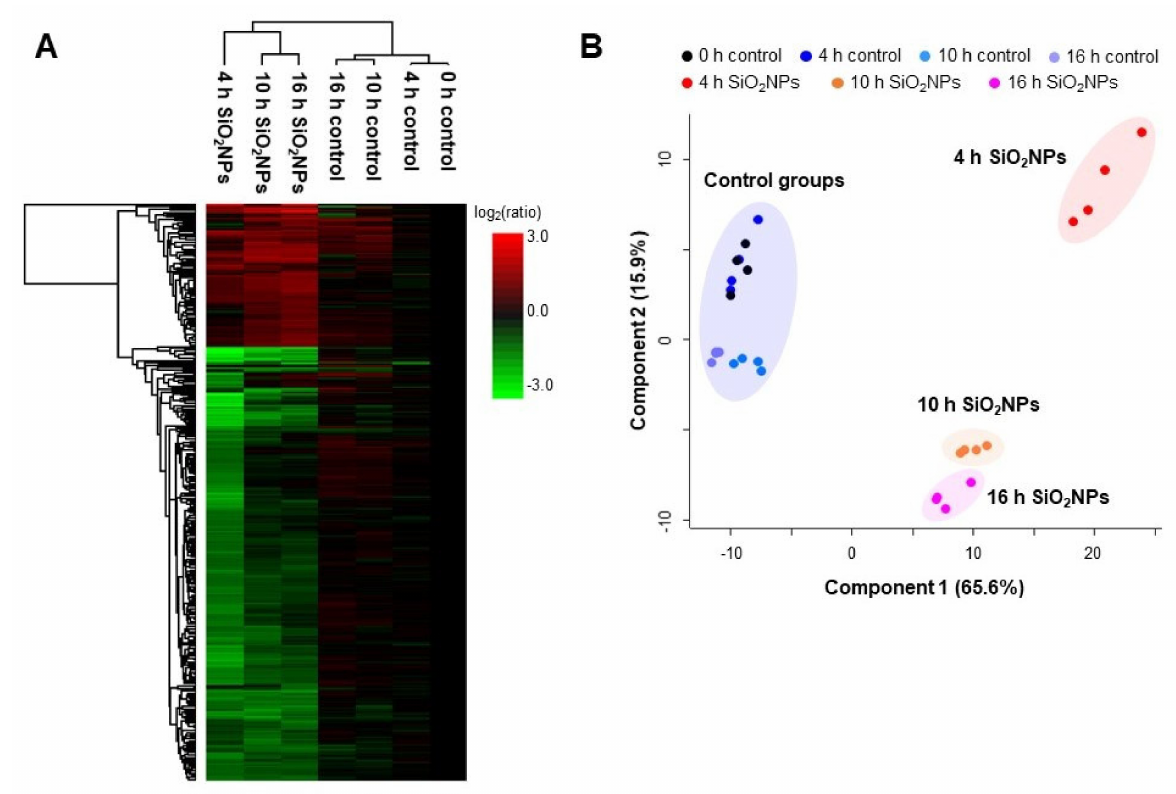
Figure 5. ( A ) Heatmap (with hierarchical cluster analysis) and ( B ) principal component analysis of the differentially expressed proteins from SiO 2 NPs-treated HepG2 cells in increase of exposure time in comparison to the 0 h group. The filled circles of the same color represent four